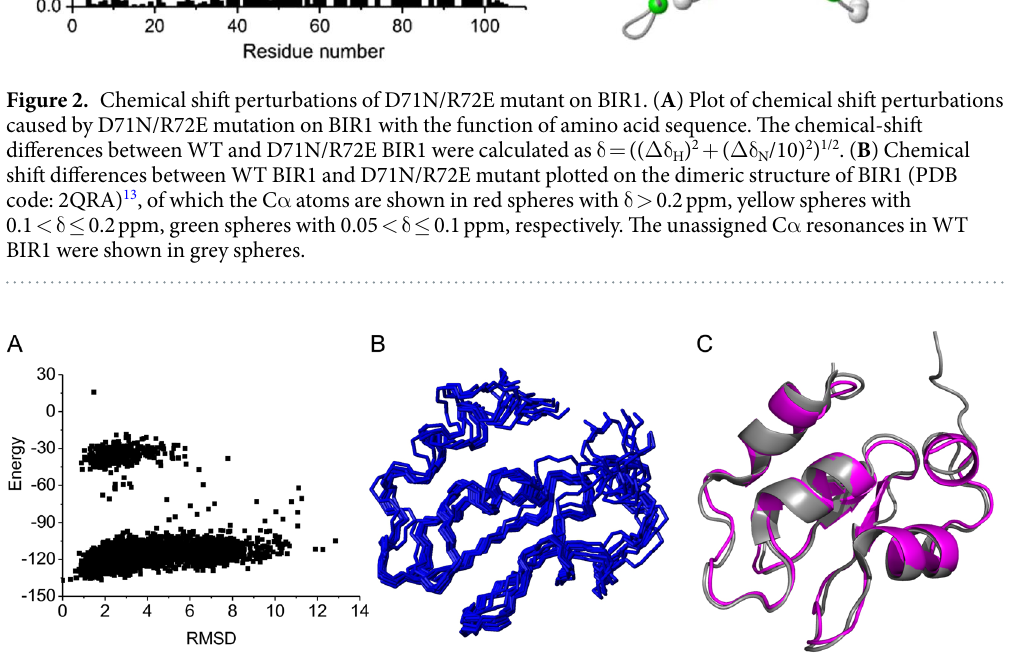
Figure 3. Solution structure of D71N/R72E BIR1 determined by CS-Rosetta. ( A ) Plot of Rosetta all atom energy versus ∀ C RMSD relative to the lowest energy model. ( B ) Ensemble structural representation of 10-lowest energy conformations of D71N/R72E BIR1 calculated by CS-Rosetta. ( C ) Structural comparison of the lowest energy solution structure of D71N/R72E BIR1 from CS-Rosetta calculation (magenta) and X-ray crystal structure of WT BIR1 (grey) (PDB code: 2QRA) 13